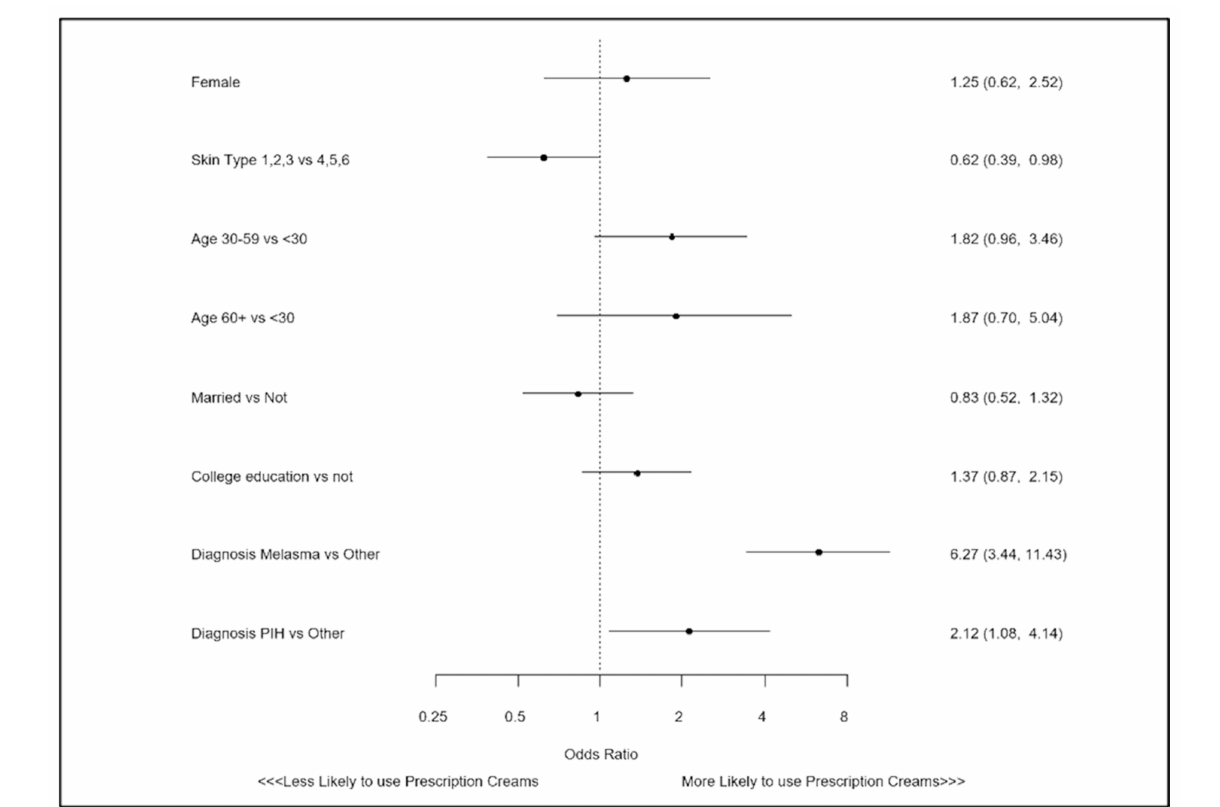
Figure 1. Factors associated with use of a prescription lightening